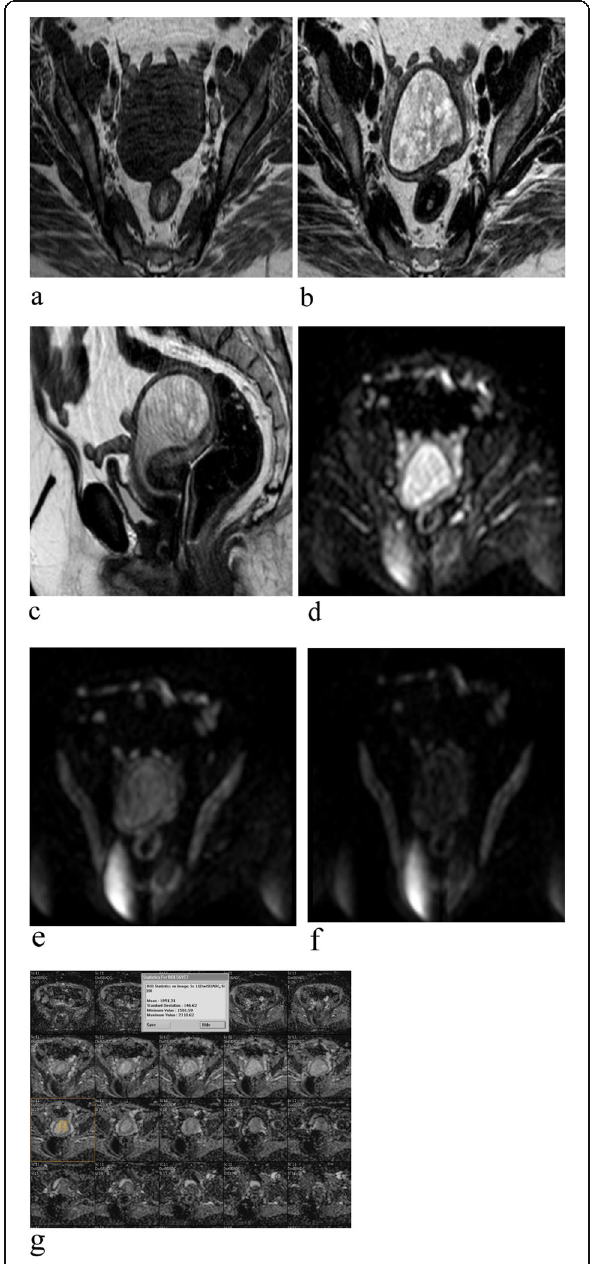
Fig. 2 Axial T1-WI ( a ) revealed a hypointense signal intensity from the thickened endometrium. Axial T2- ( b ) and sagittal T2-WI ( c ) revealed diffuse thickening of the endometrium forming a mass-like lesion with a homogenous, high SI, and no infiltration of the junctional zone. Diffusion-weighted imaging at b = 0 ( d ), b = 500 ( e ), and b = 1000 ( f ) showed that the thickened endometrium lost its high SI with increasing b values (benign feature). ADC mapping ( g ) showed a homogenous high SI from the thickened endometrium with an ADC of 1.891 × 10 − 3 mm 2 /s. Radiological diagnosis: benign featuring increased endometrial thickening forming a mass-like lesion likely endometrial hyperplasia. Final diagnosis (according to histopathology): endometrial